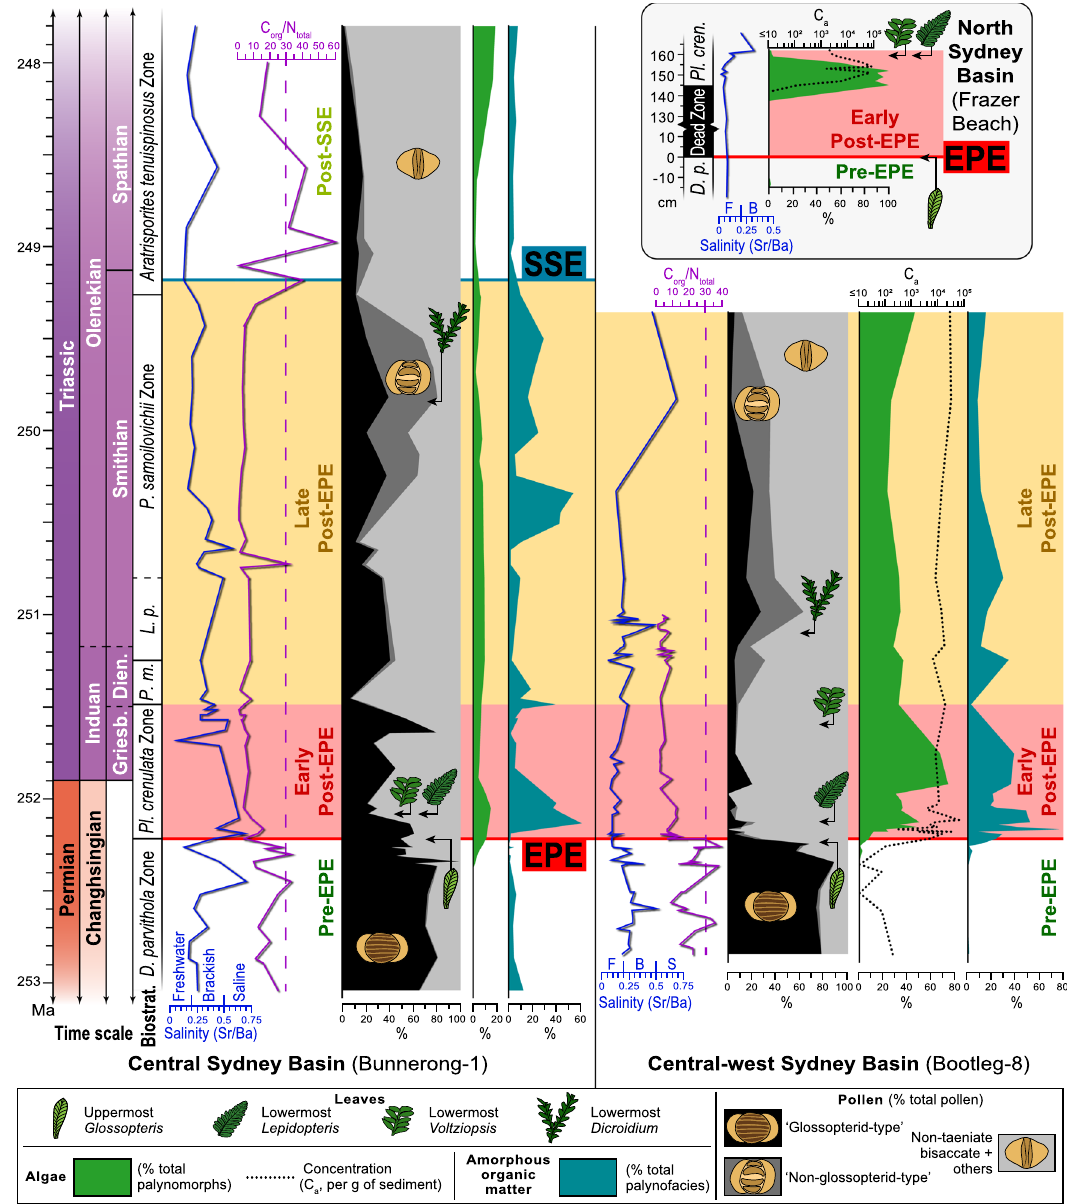
Fig. 2 Microfossil and geochemical trends from the upper Permian to Lower Triassic of the Sydney Basin, Australia. Data from Bootleg-8 and Bunnerong-1 are rescaled to the global chronostratigraphic scheme by anchoring spore-pollen biostratigraphic zone (biostrat.) boundaries to high-precision radiogenic isotope ages within the eastern Australian succession 13 – 15 as calibrated in refs. 10,14 . Bunnerong-1 amorphous organic matter and algal data from ref. 13 . Salinity category values follow ref. 82 . B brackish, F freshwater, S saline. Dashed lines at C org /N total = 30 for ease of comparison between successions. Note: glossopterid-type pollen were produced by both glossopterids and some other seed plants, “ last Glossopteris ” refers to leaf remains, not “ glossopterid-type ” pollen. “ Dead zone ” from ref. 16 , EPE = end-Permian extinction event, Ma = millions of years ago, SSE = Smithian-Spathian